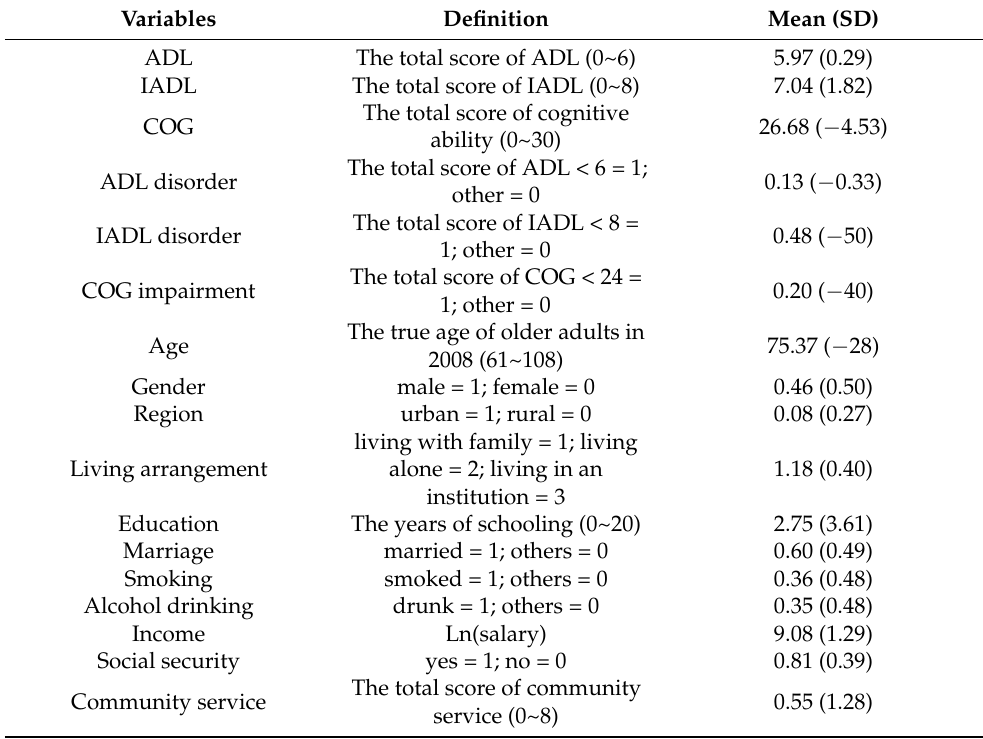
Table 1. Descriptive statistical analysis of samples in